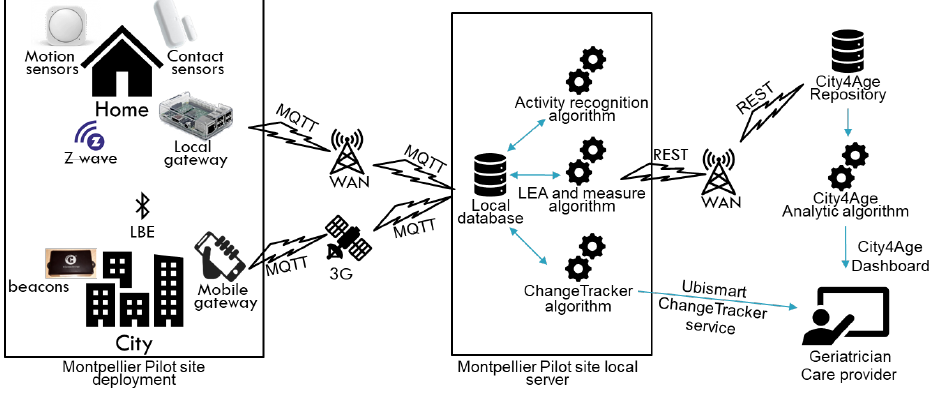
Figure 4. Complete architecture of Montpellier pilot site’s